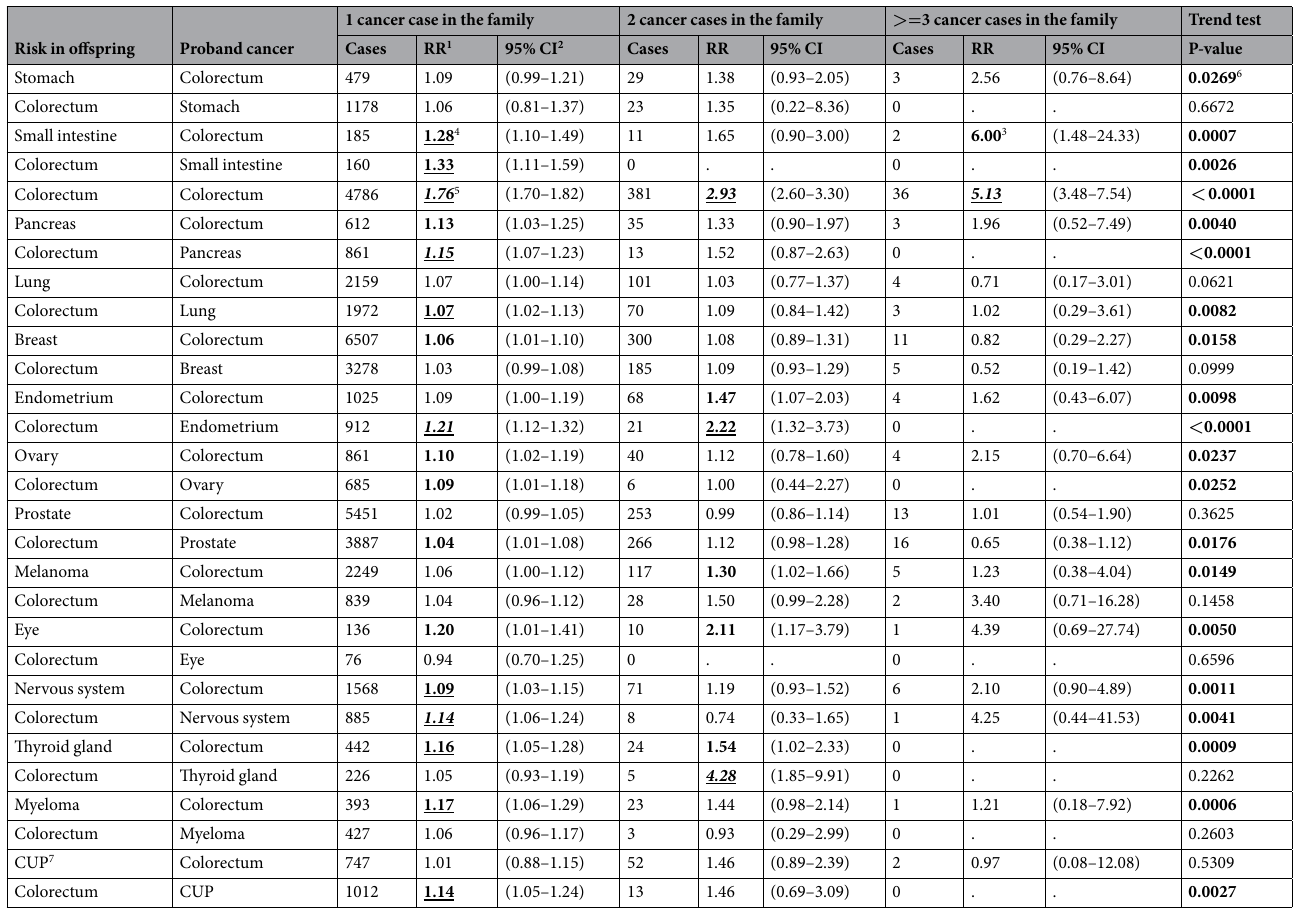
Table 1. Discordant and concordant risks for CRC. 1 RR = relative risk. 2 CI = confidence interval. 3 Bold type denotes significantly increased RR at the two-sided 5% level. 4 Bold and underlined value denotes significantly increased RR at the two-sided 1% level. 5 Bold, underlined and Italics value denotes significantly increased RR at the two-sided 0.1% level. 6 Bold type denotes that trend test was statistically significant. 7 CUP = cancer of unknown